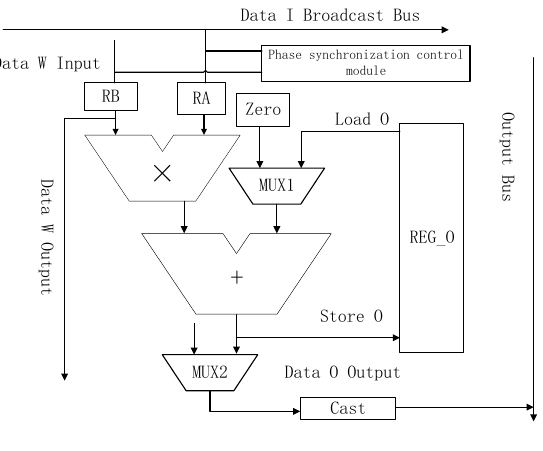
Figure 11. Sensors 2020 , 20 , x FOR PEER REVIEW